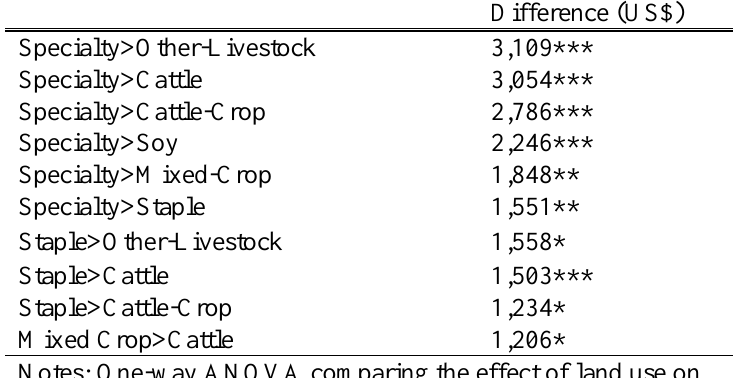
Table A3. 2: Tukey tests for per hectare farm income by land use